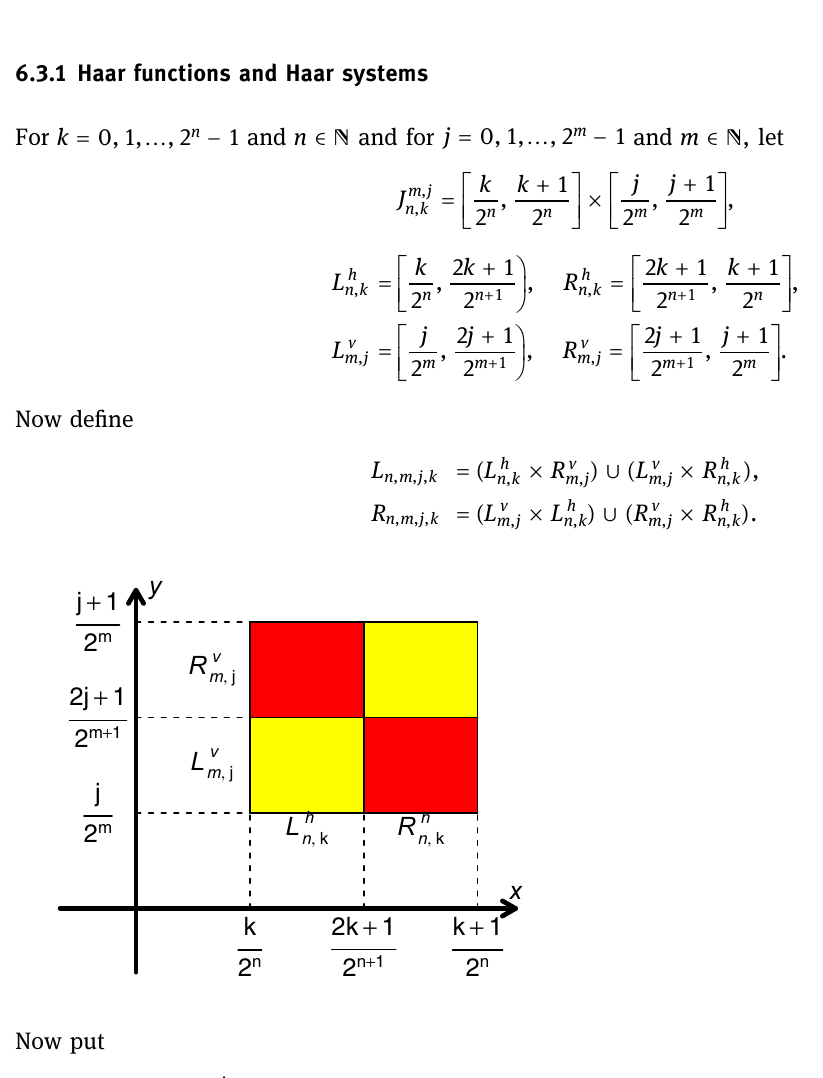
Figure 4: An illustration of ( ) ψ x y , and ( ) ϕ x y ,